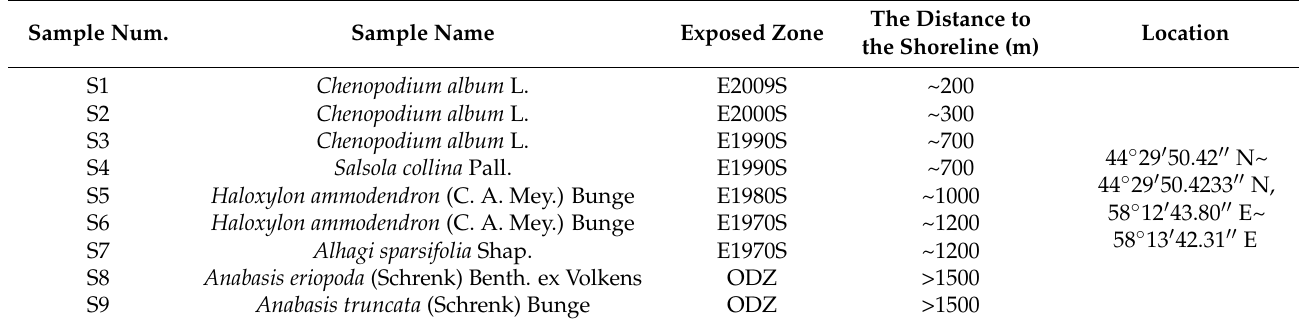
Table 1. Samples information.